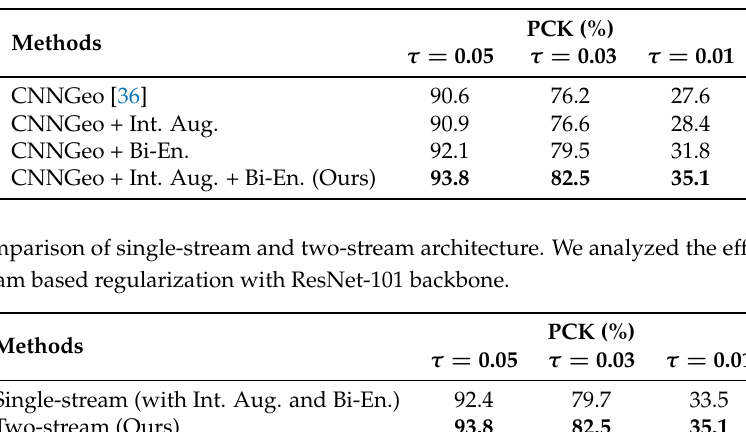
Table 2. Results of models with different additional components. We analyzed the contributions of each component with ResNet-101 backbone.